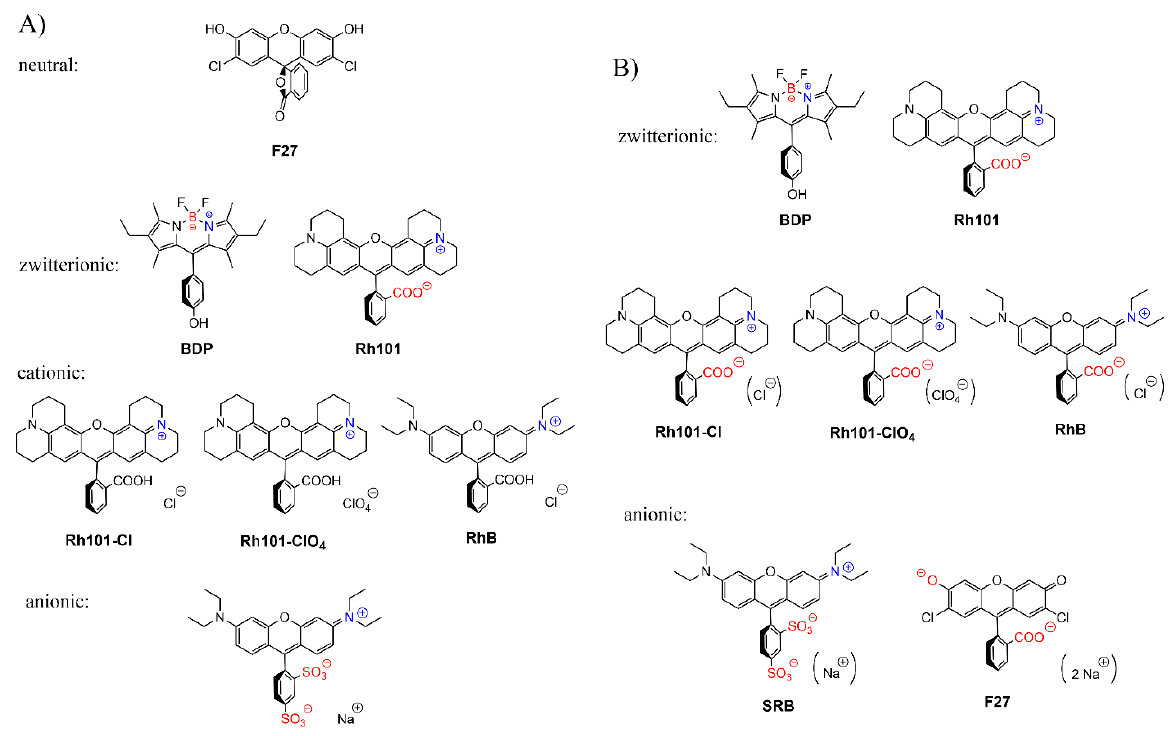
Figure 6. Prevalent charge states of the dyes in ( A ) acetonitrile and ( B ) phosphate-buffered saline (PBS) buffer at pH 7.4. Positively charged moieties are highlighted in blue, negatively charged in red; brackets around counter-ions in ( B ) denote that these species are well-solvated in PBS and are not involved in ion-pairing.